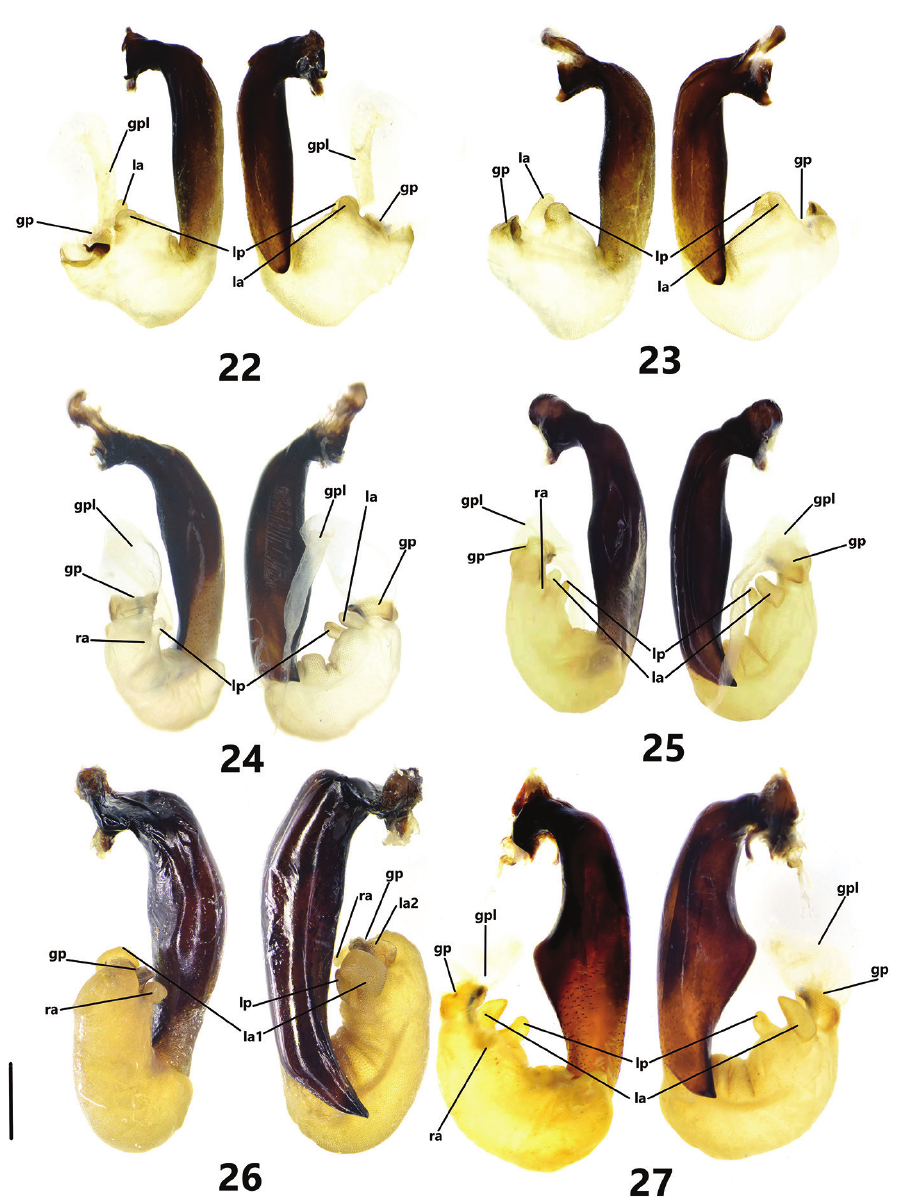
from Changbaishan mt., Jilin 24 P. syleus Kirschenhofer, a male from Fengcheng city, Liaoning 25 P. syleus Kirschenhofer, a male from Shedao Island, Liaoning 26 P. quadrilobatus sp. nov., Holotype 27 P. bellatrix Tschitschérine, a male from Changbai county, Jilin. Scale bar: 1